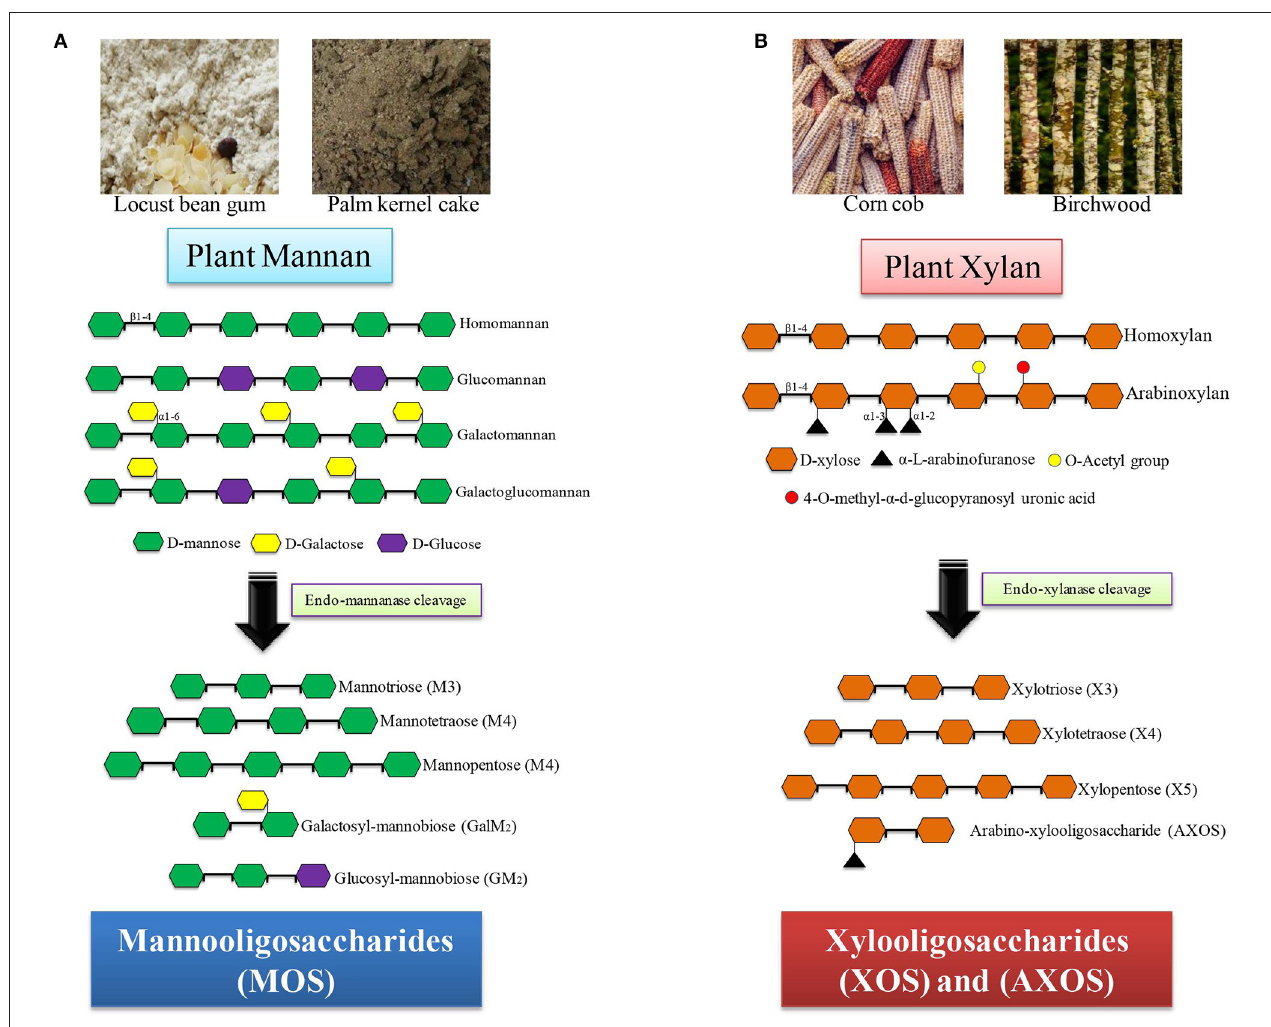
FIGURE 1 | Sources and structure of hemicelluloses-derived oligosaccharides (HDOs). (A) Mannan containing substrates (locust bean gum, palm kernel cake) produce different mannooligomers after mannanase treatment. (B) Xylan containing substrates (corn cob, birchwood) produce xylooligomers after xylanase